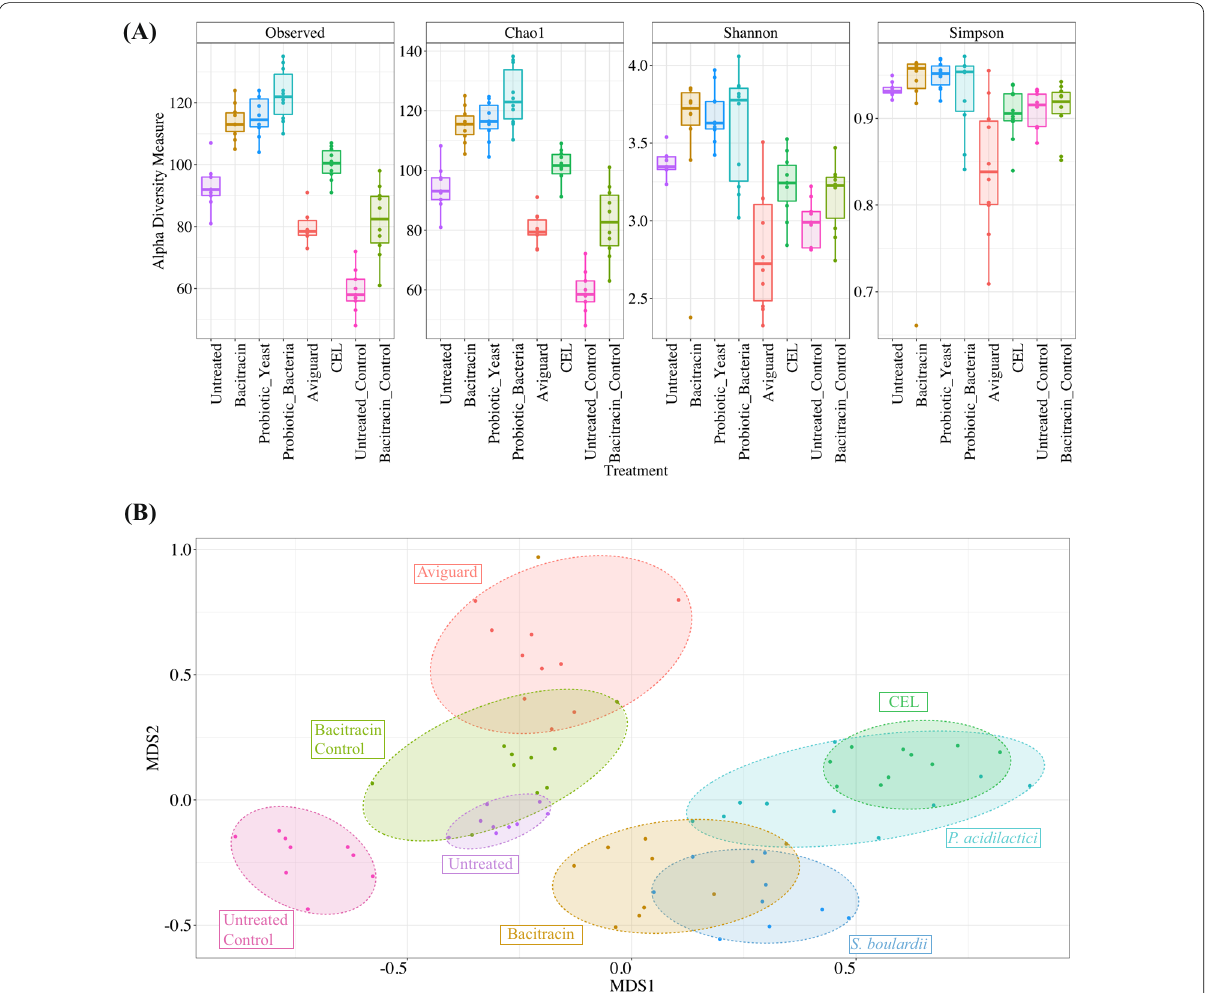
Fig. 2 Alpha and beta diversity of cecal microbial communities. A Boxplots representing alpha diversity metrics of richness (observed number of OTUs and Chao1) and evenness (Shannon and Simpson) for 39‑day samples grouped according to treatment (no. of OTUs at 97% similarity). Each point represents the diversity score for a sample, colour‑coded according to treatment. B Non‑metric multidimensional scaling (nMDS) plot based on Bray–Curtis dissimilarity matrix on relative abundance data in 39‑day samples. Colours indicate treatment